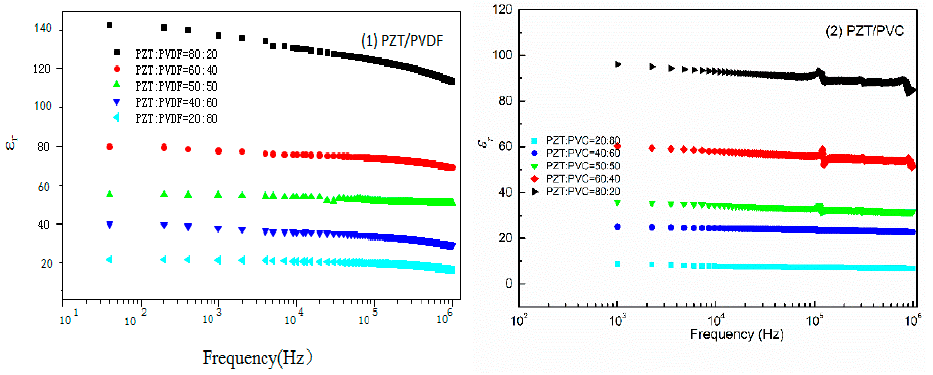
Figure 5. ( a ) Variation of dielectric constant of PZT/PVDF composites with frequency; ( b ) Variation of dielectric constant of PZT/PVC composites with frequency.